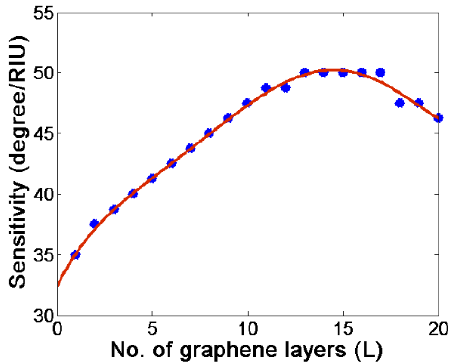
Figure 2. Sensitivity variation with no. of graphene layers for a gas sensing probe with 50 nm of Au and 11 nm of silicon layer thickness. Maximum sensitivity is calculated to be 50 degree/RIU. The circle symbols are simulated data points, which are fitted with red line.